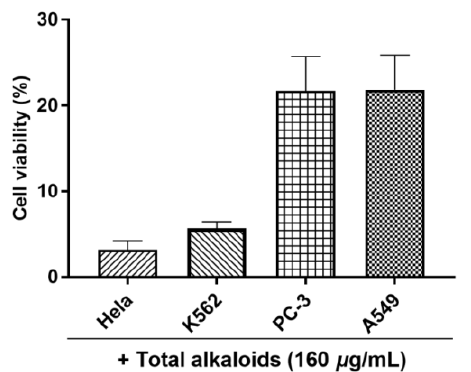
Figure 6. The cell viability of A549, Hela, K562, and PC-3 cells treated with the total alkaloids of G. elegans at a concentration of 160 ug/mL.